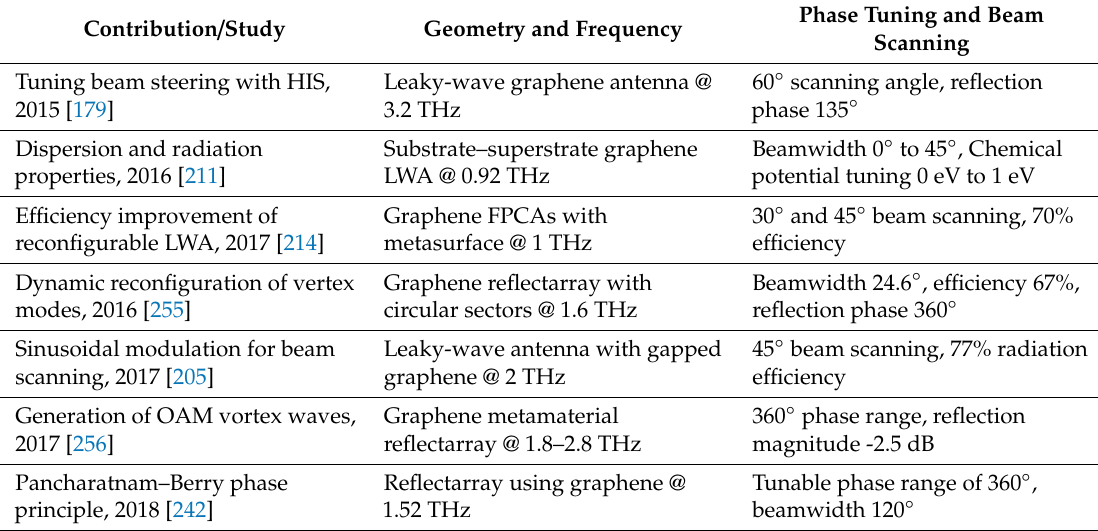
Table 3. Summary of graphene leaky-wave and reflectarray antennas as discussed in Section 5. FPCA: Fabry–Perot cavity antenna; OAM: orbital angular